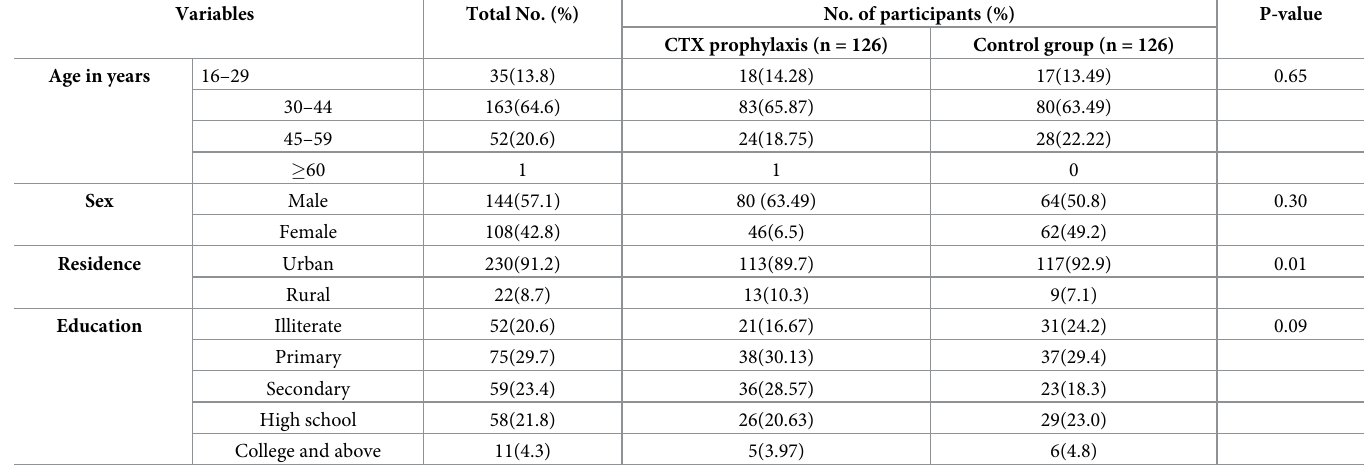
Table 1. Socio-demographic characteristics of HIV patients undergoing CTX prophylaxis compared with the control group from April 01 to August 31, 2018, Arba Minch, Ethiopia (n = 252).